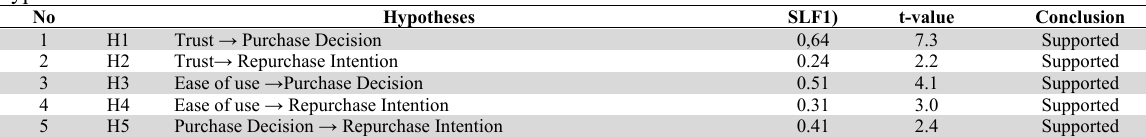
Hypothesis test